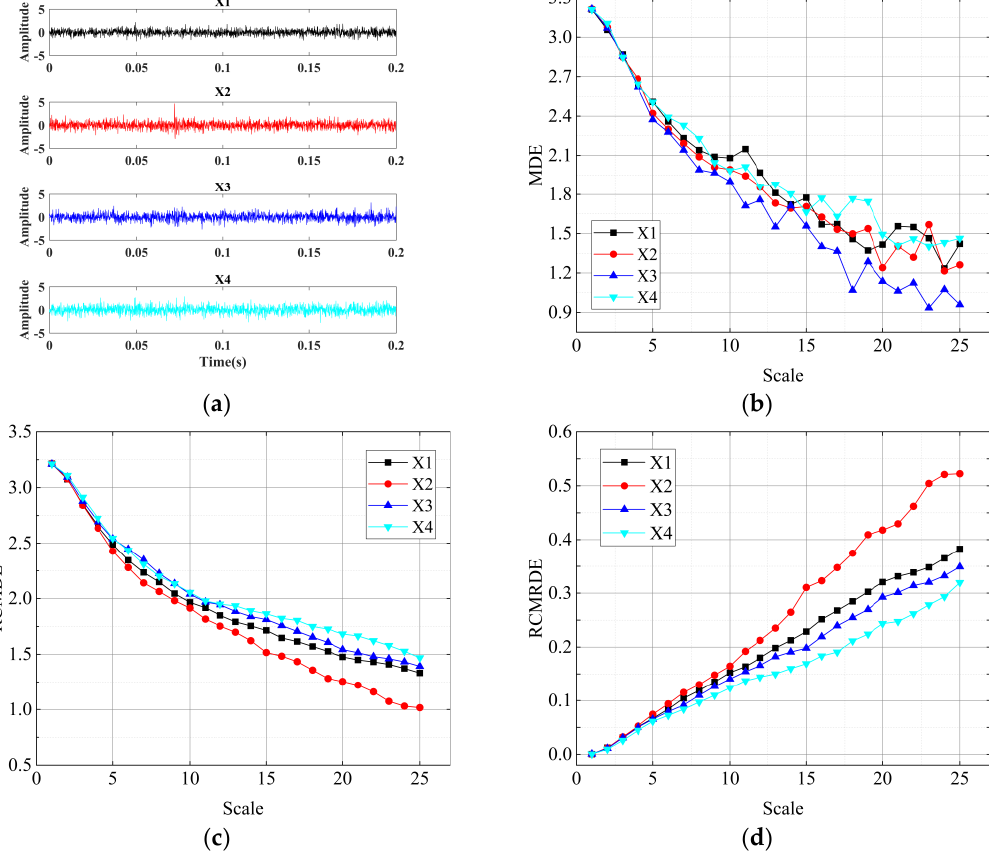
Figure 5. Simulation signals and corresponding three entropy values: ( a ) four bearing outer fault